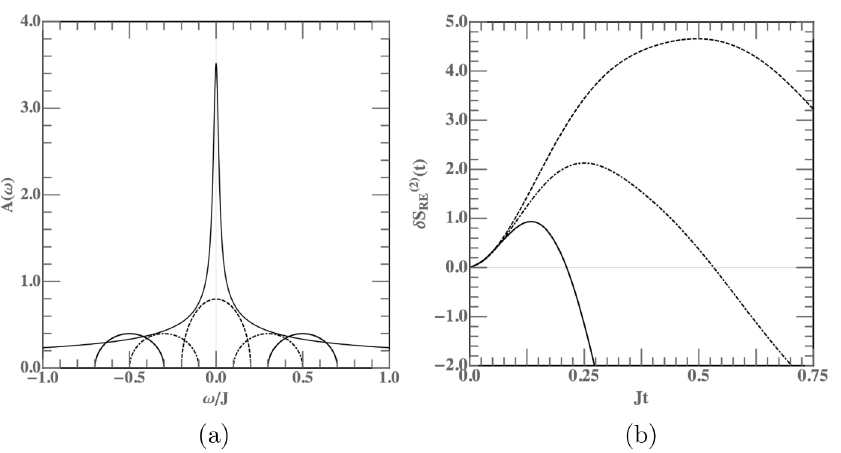
Figure 5 . Here we take J = 4 , β = 10 , J 0 = 0 . 8 . In (a) we give the spectral function of the system and the environment. The dashed line is for µ = 0 . , dot-dashed line is for µ = 1 . 2 and the solid line is for µ = 2 . The gap of the spectrum is increasing from 0 to 1.2. In (b) we show the Rényi entropy response for β E = 2 , µ = 0 . as dashed line; µ = 1 . 2 case as dot-dashed line and µ = 2 . as solid